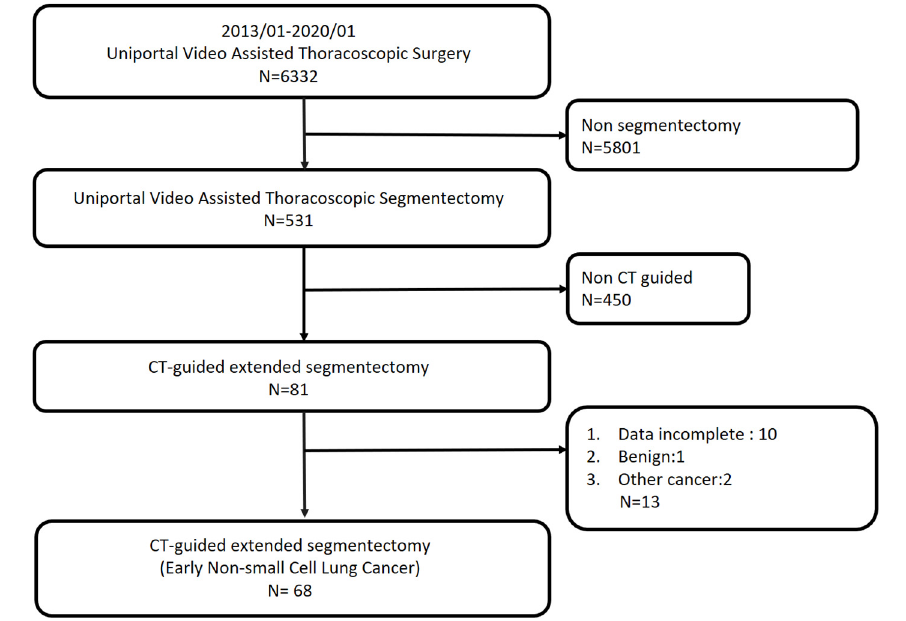
Figure 3. Algorithm for patient selection.